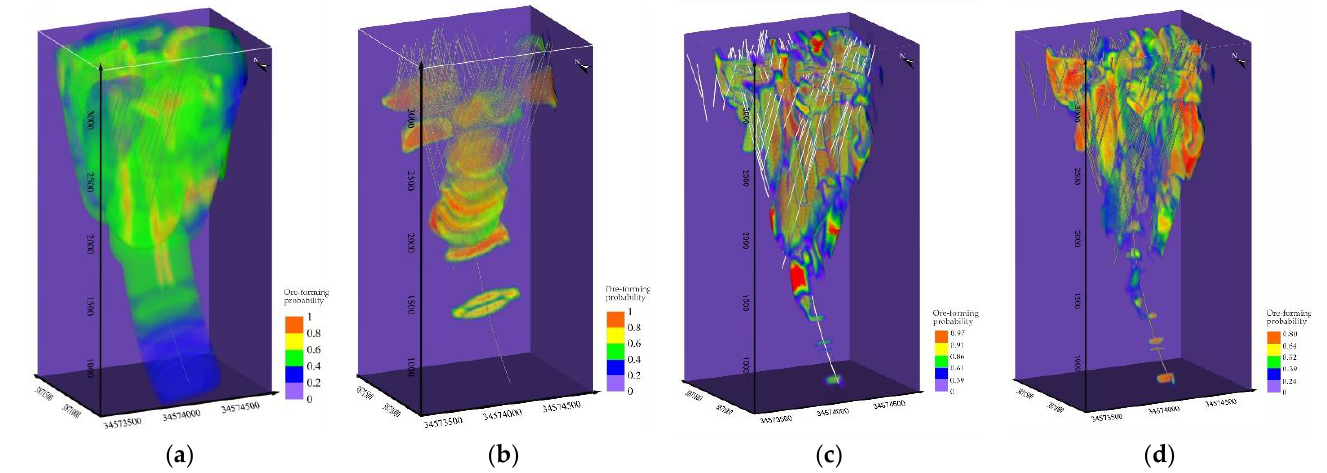
Figure 13. Comparison of the 3D MPM of 4 methods. ( a ) MaxEnt mode. ( b ) GMM. ( c ) DAE model. ( d ) STOAD model.